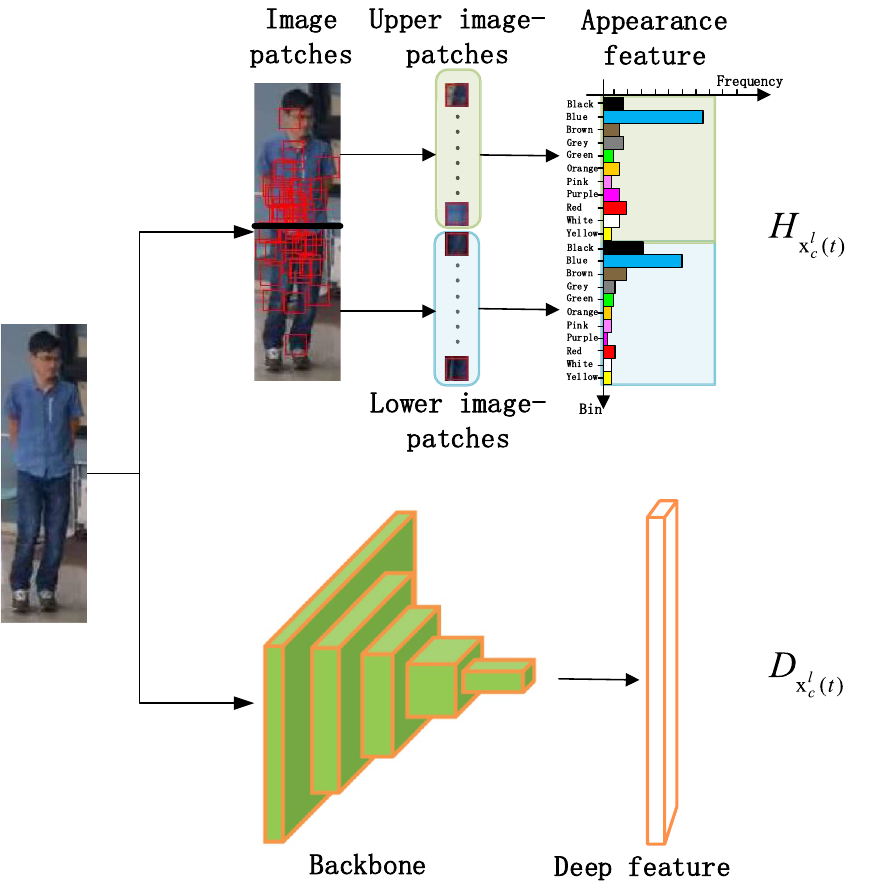
Figure 3. Appearance feature (top) as the concatenation of upper (light green) and lower (light blue) histograms and deep feature (bottom) extracted from a backbone